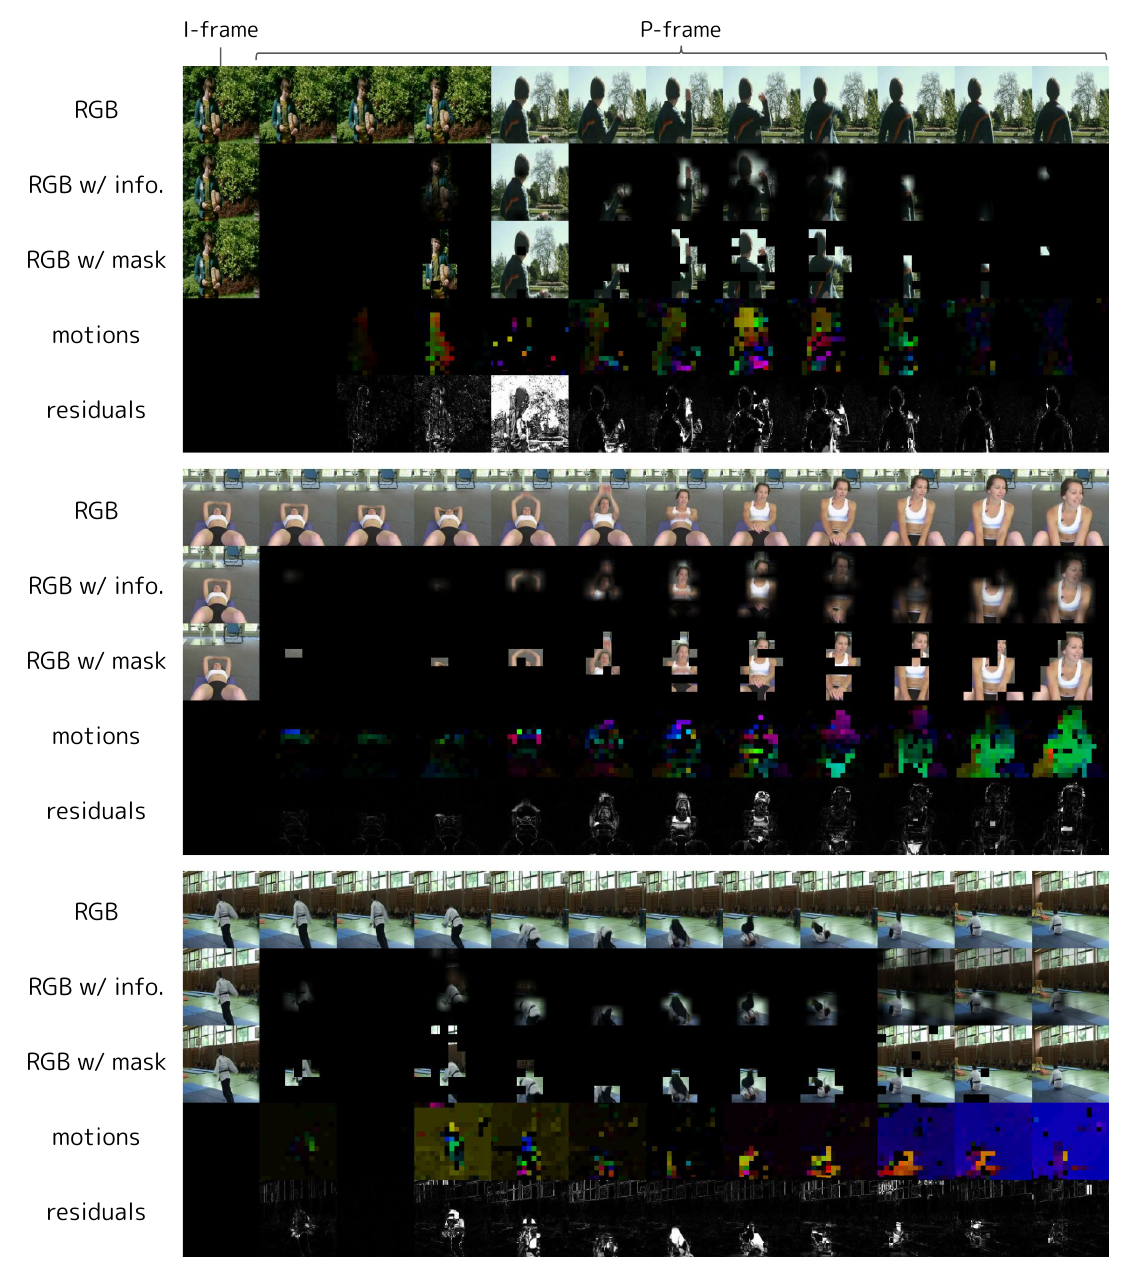
Figure 5. Visualization of GoPs processed by IPS in HMDB-51. Each GoP is displayed by a group of five rows (three GoPs are displayed). The first row of each GoP represents the original frames, the second represents the frames overlaid with information content calculated by Equation (10), the third represents the frames overlaid with the mask obtained by thresholding the information content, the fourth represents the motions, and the fifth represents the residuals. We plot motions in HSV space, where the H channel encodes the direction of motion, and the S channel shows the amplitude. For residuals, we plot the mean absolute values of RGB. All rows are in chronological order from left to right. The leftmost frames are I-frames and, therefore, not subject to